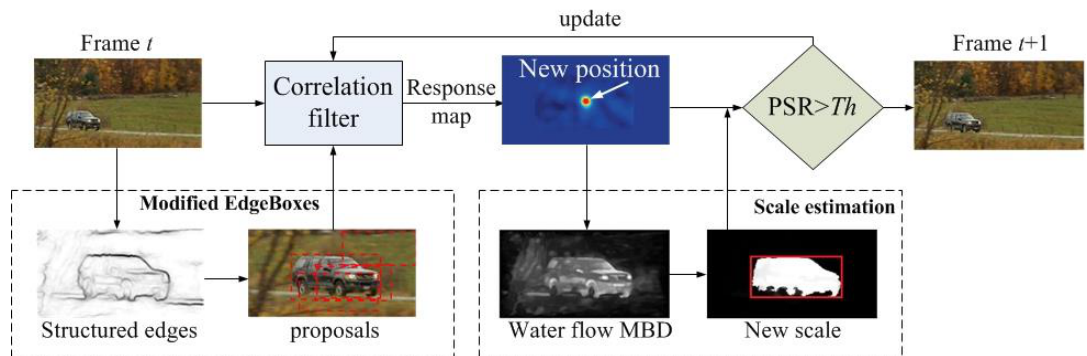
Figure 1. Illustration of the proposed Correlation Filters based Scale Adaptive tracking method.